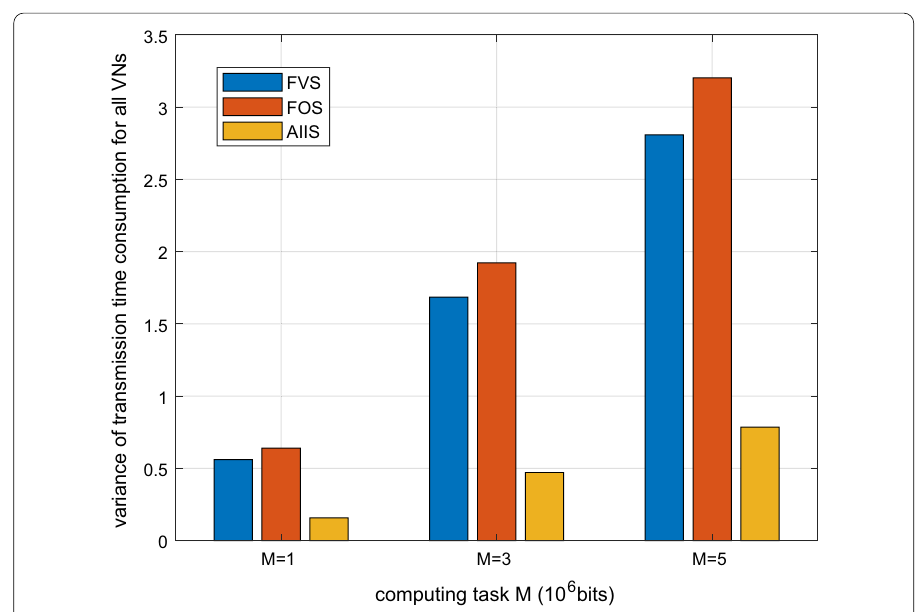
Fig. 9 The variance of transmission time consumption of vehicle nodes (VNs) under different computation task